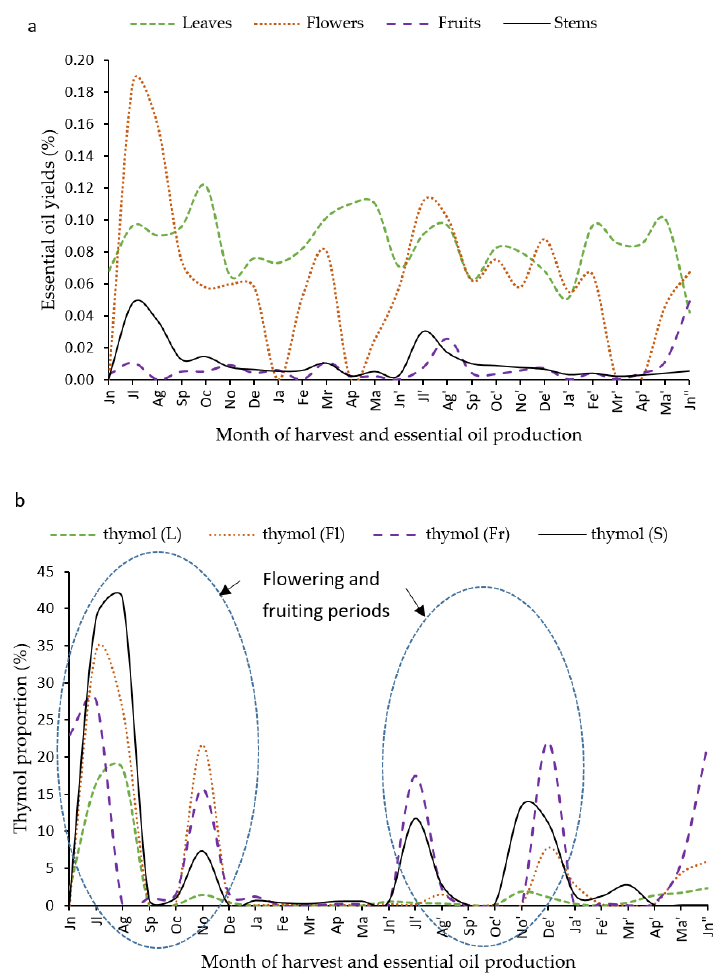
Figure 1. ( a ) Essential oil yield of L. camara organs from each month during two harvest periods. ( b ) Variation of thymol proportion in essential oil of L. camara organs from each month.